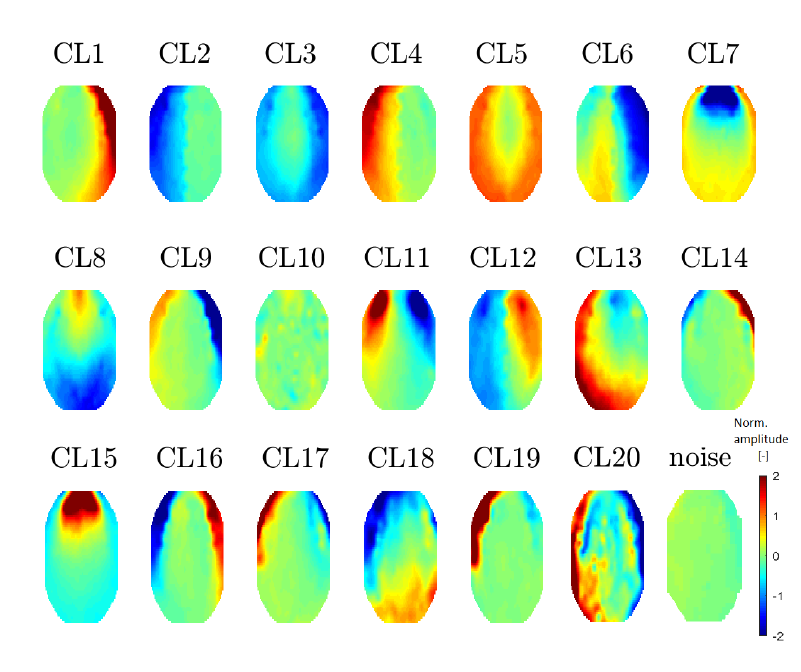
Figure 7. Mean topomaps representing 20 clusters after using the t-SNE method with a perplexity of 30. A perplexity of 40 had the same topomaps that differed in sequence. The mean and median topomaps have similar characters but the variance has no meaningful value. Topomaps were clustered from IC space.